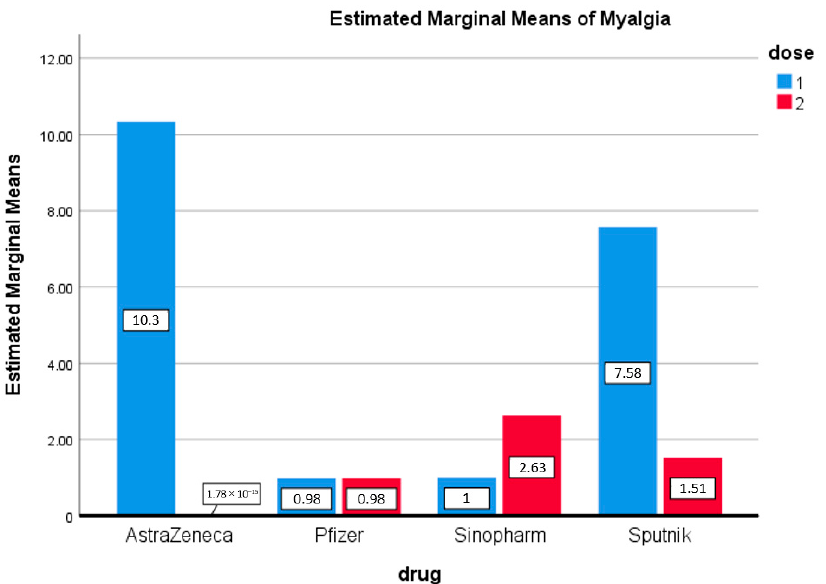
Figure 4. Myalgia. Estimated marginal means of myalgia after first and second doses of vaccines used in the Kingdom of Bahrain.